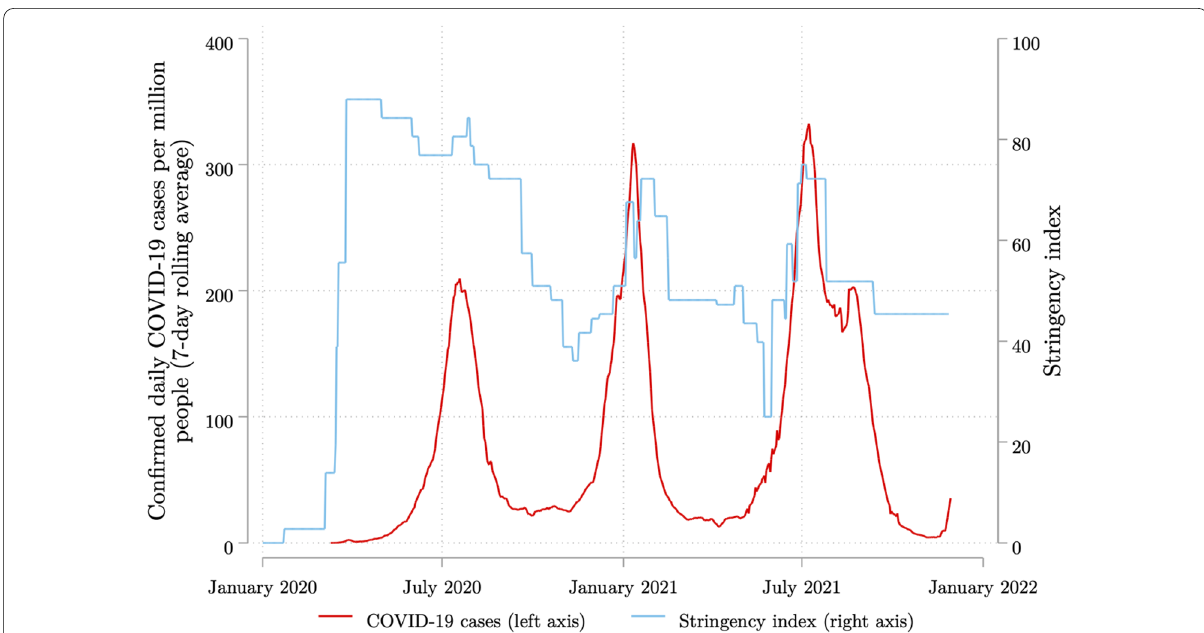
Fig. 1 Trajectories of COVID-19 cases and lockdown stringency in South Africa, 2020 and 2021. Author’s own arrangement. Source : Our World in Data (Ritchie et al. 2020); Oxford Covid-19 Government Response Tracker (OxCGRT) dataset (Hale et al. 2020). Notes : This figure presents the 7-day rolling average of confirmed daily COVID-19 cases and the government policy stringency index values over time. The stringency index measures the strictness of policies that restrict people’s behaviour, calculated using data on nine indicators of government containment and closure policy and public information campaigns. The index ranges from 0 to 100 with higher scores indicative of stricter policy